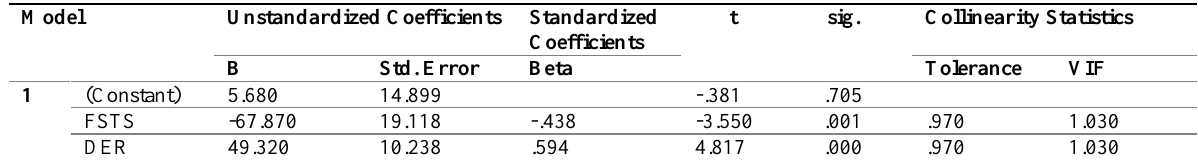
Table 6: The Regression Coefficient